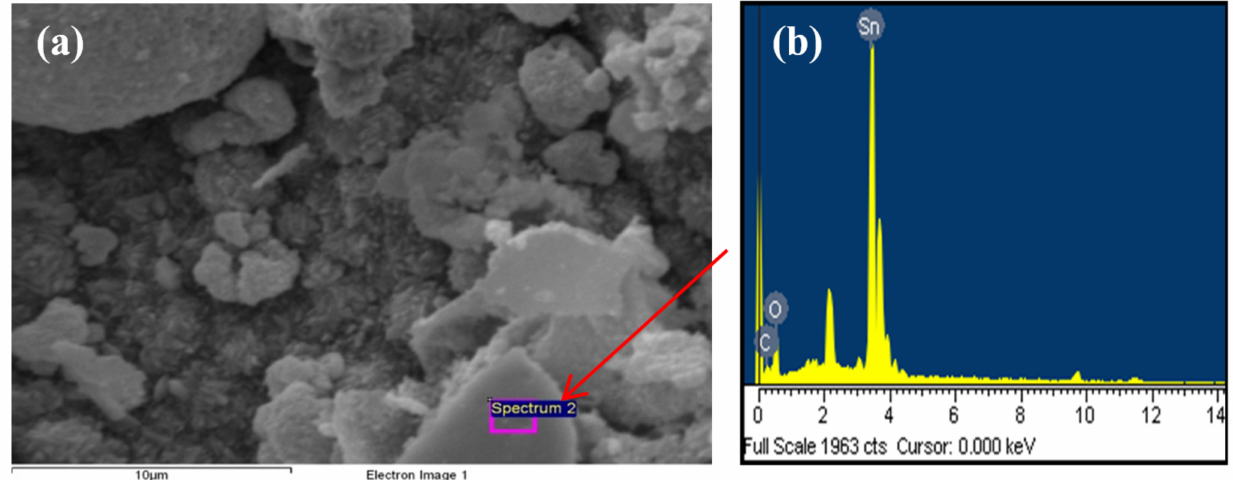
Figure 13. SEM image ( a ) and EDS analysis ( b ) of the SnO 2 obtained from PS-co-4-PVP · (SnCl 2 ) n precursor. Nanostructured ZnO was also obtained from the macromolecular chitosan · (ZnCl 2 ) and PSP-co-4-PVP · (SnCl 2 ) n complexes